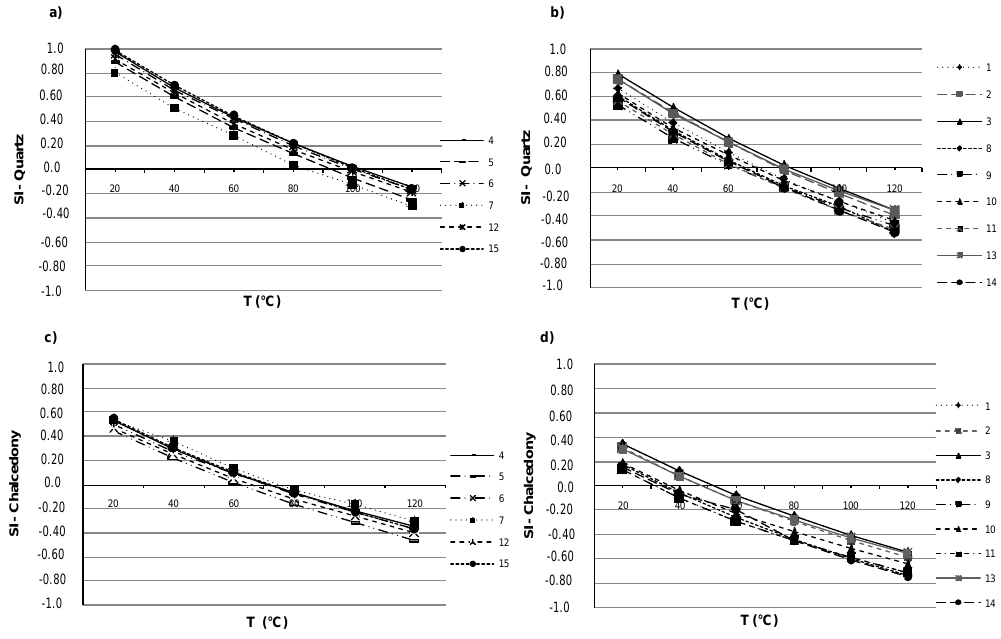
Fig. 5. Result of the geothermometric simulations: a) Quartz saturation index for the samples with equilibrium temperature between 85-110ºC, b) Quartz saturation index for the samples with equilibrium temperatures between 63-85ºC, c) Chalcedony saturation index for the samples with equilibrium temperatures between 45-85ºC, d) Chalcedony saturation index for the samples with equilibrium temperatures between 35-65 ºC.